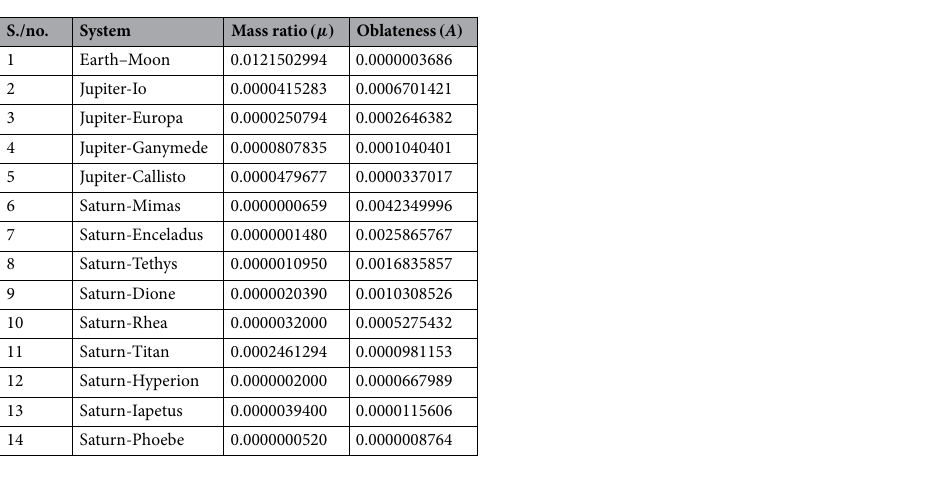
Table 2. Systems and their parameters. Sources: Sharma and SubbaRao 32 .